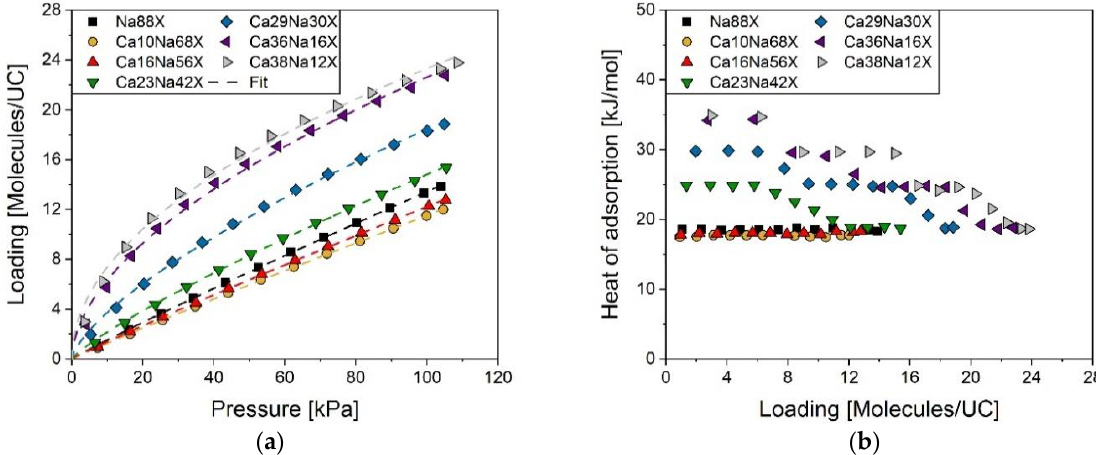
Figure 2. ( a ) Adsorption isotherms of methane on Na 88 X and CaNaX zeolites at 298.15 K; ( b ) Load-dependent heats of adsorption of methane on Na 88 X and CaNaX zeolites at 298.15 K.